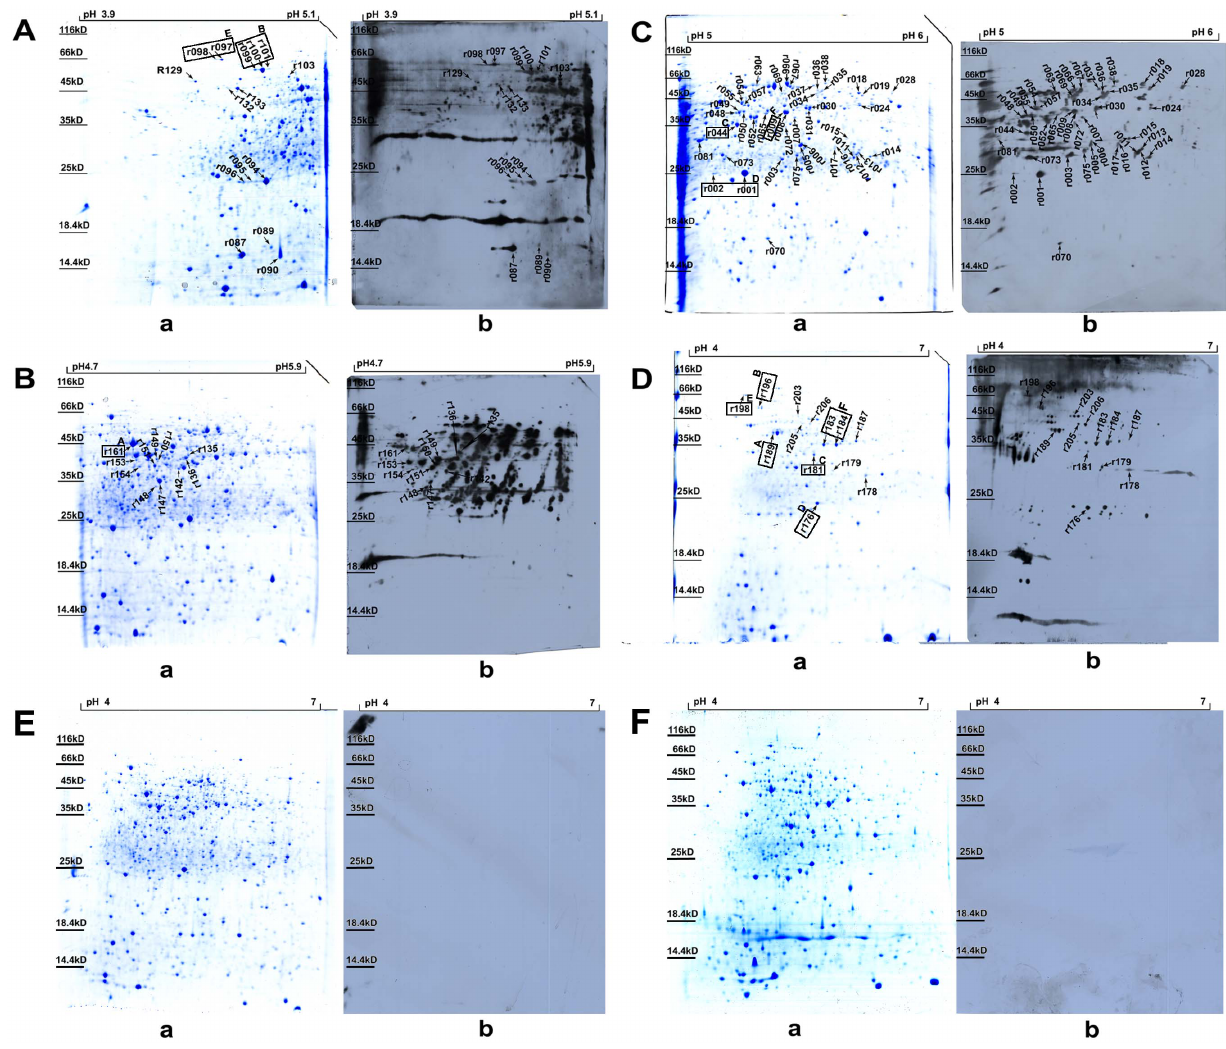
Figure 1. 2-DE map and corresponding western blotting image of B.anthracis A16R vegetative and spore proteins. (A–C) Vegetative proteins for the pH 3.9–5.1, 4.7–5.9 and 5–6 strips, respectively. (D) Spore proteins for the pH 4–7 strip. (E and F) Vegetative and spore proteins for the pH 4–7 strips, respectively. (a and b) for A–D indicate 2-DE maps and the corresponding western blotting images using rabbit immune sera against B.anthracis live spores, respectively. (a and b) for E and F indicate 2-DE maps and the corresponding western blotting images using rabbit unimmunized sera, respectively. The spots whose names are in boxes indicate that those proteins were identified in both vegetative and spore proteins. The same upper case letter indicates the same protein in the vegetative and spore proteins.